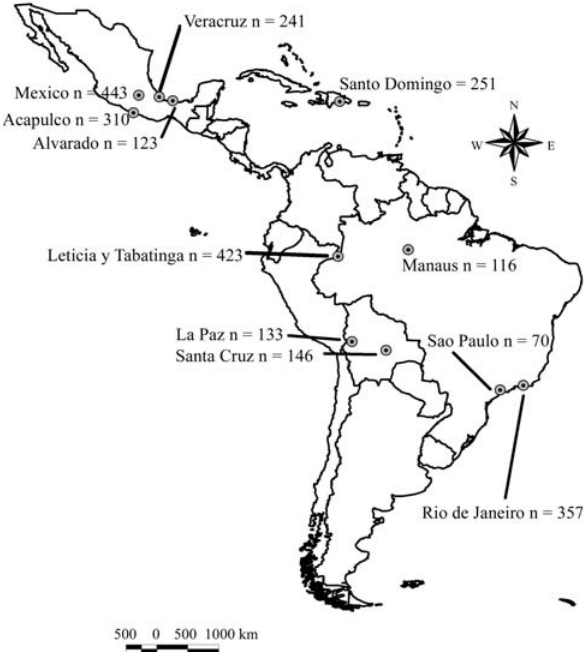
Figure 1 - Map of the Latin American cat populations